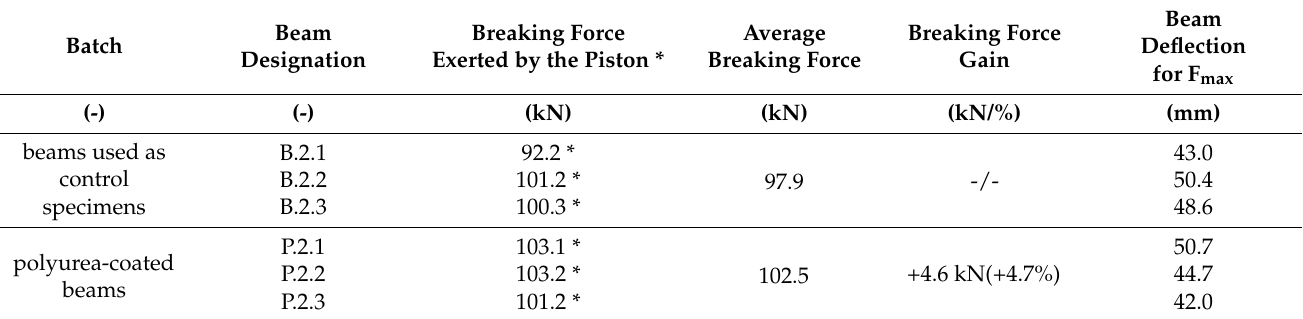
Table 6. Summary of breaking forces for each batch of RC beams.